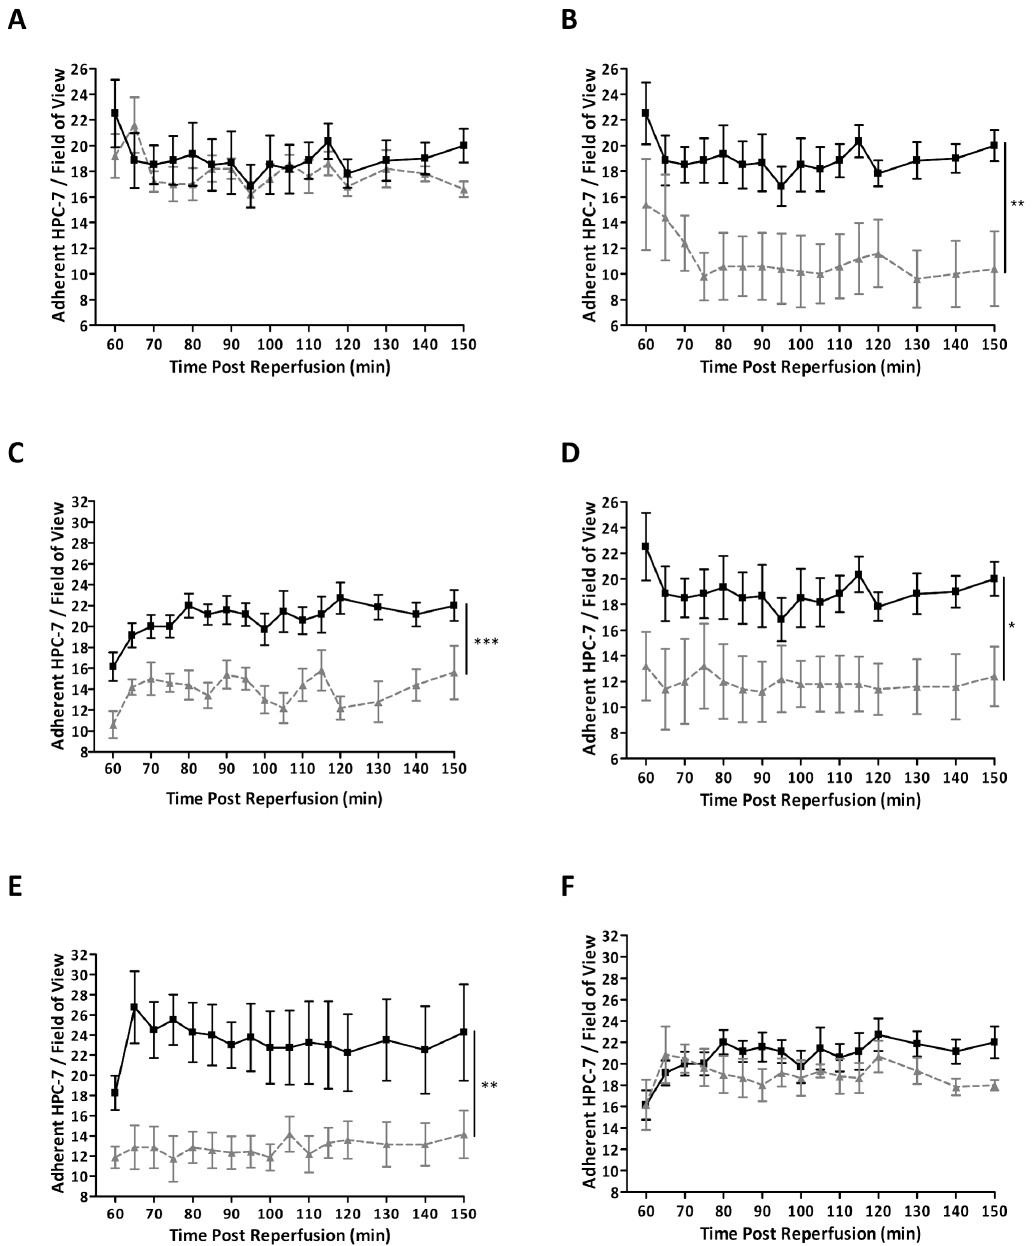
Figure 2. HPC-7 recruitment to IR injured kidney is dependant on CD44 and CD49d. 2 6 10 6 HPC-7 were pre-treated with function-blocking monoclonal antibodies (80 m g/ml) against integrins CD18 and CD49d and the non-integrin CD44. Function blocking antibodies to endothelial VCAM- 1 and CD44 and the enzyme hyaluronidase (to block HA) were administered in vivo at 1 minute post-reperfusion and 2 6 10 6 naı¨ve HPC-7 were infused at 60 minutes. No decrease in HPC-7 adhesion was observed with an anti-CD18 antibody compared to IgG control (A). Adhesion was significantly reduced by blocking CD49d (B) and also when its endothelial counter-ligand, VCAM-1, was blocked in vivo (C). Similarly, adhesion was significantly reduced by blocking CD44 on HPC-7 (D) and also when its endothelial counter-ligand, HA, was blocked in vivo (E). Blocking endothelial CD44 did not decrease HPC-7 adhesion (F). For all graphs: IgG controls = solid line; blocking treatments = dashed line. Results are presented as mean 6 SEM (n $ 4). *p , 0.05, **p , 0.01, ***p , 0.001.